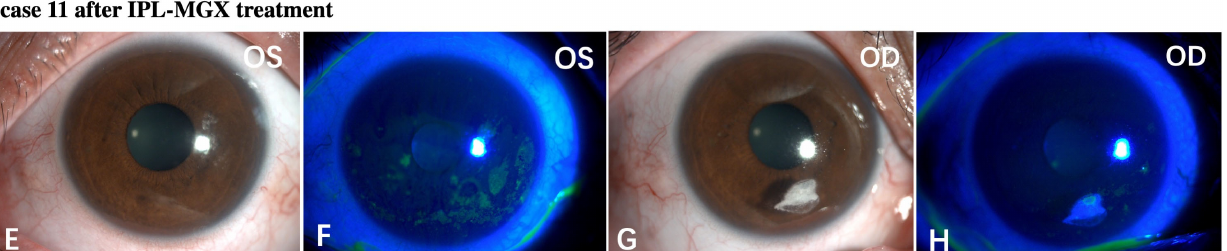
Figure 6. Case 11 in the IPL ‐ MGX group exhibited considerable improvement in the ocular surface condition from baseline to last follow ‐ up assessment. Images of the ocular surface and corneal flu ‐ orescein staining of both eyes at baseline ( A – D ) and during the last follow ‐ up visit ( E – H